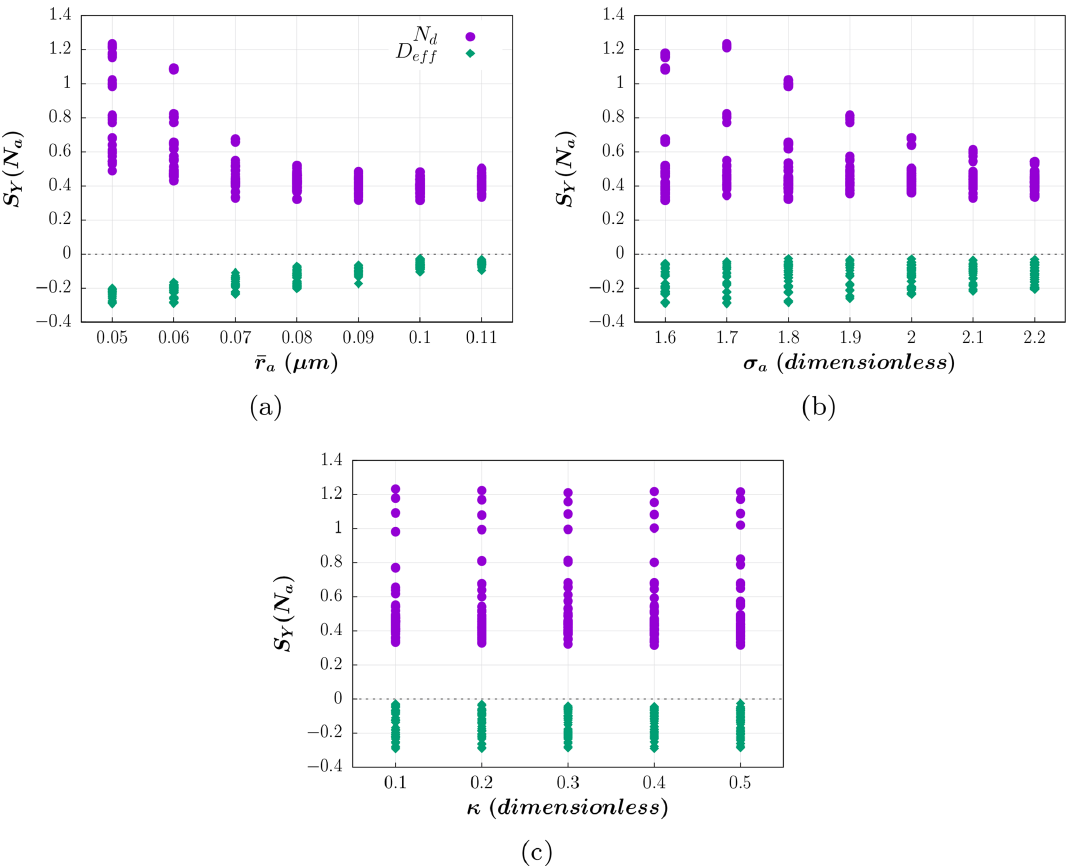
Figure 4. Sensitivities of the droplet number concentration and effective diameter to the aerosol number concentration, S Y (N a ) , as a function of (a) the median radius of the PSD (µm), (b) the geometric standard deviation of the PSD (–) and (c) the aerosol hygroscopicity